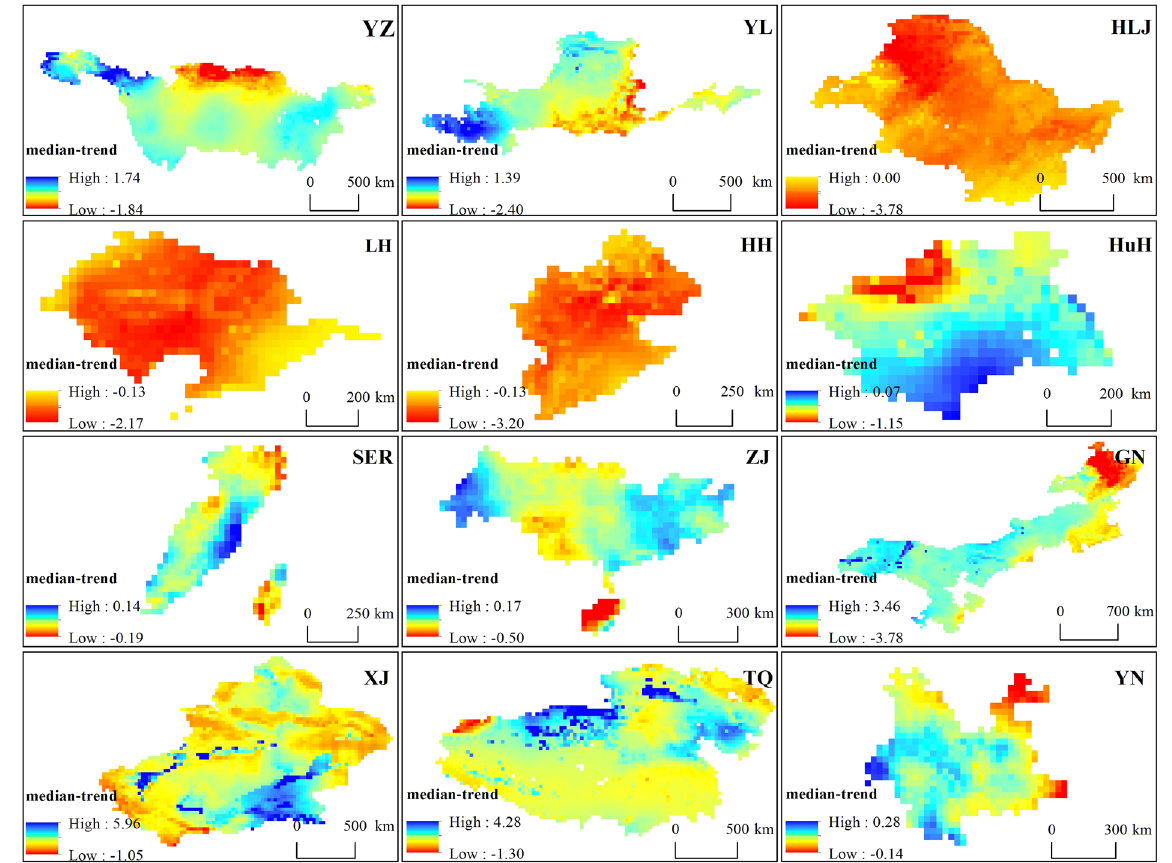
Figure 4. Spatial distribution of the annual average TWS change trend in each key zone. These results were performed by MATLAB 2013b and this map was created using ArcGIS 10.1 software, visit http://desktop.arcgis. com/en/ for more details.